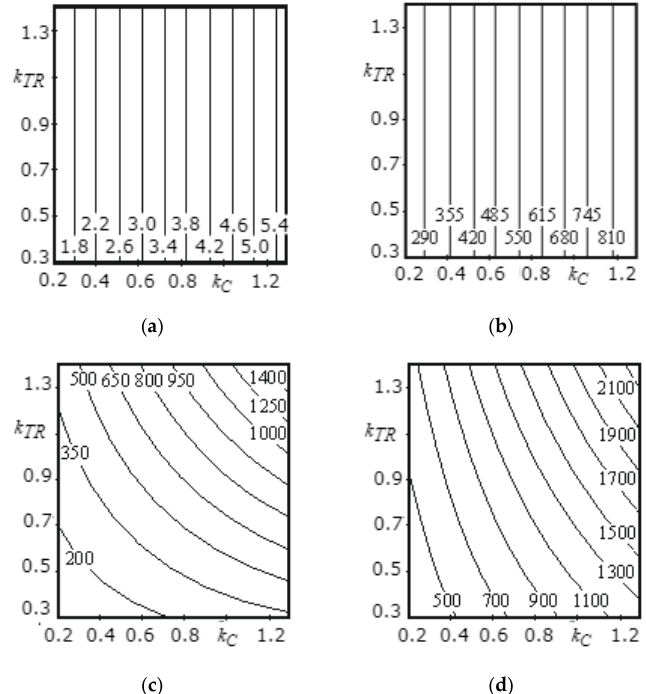
Figure 9. Dependence of the power value on the material coefficient of friction against steel and a material against material for the middle screw: ( a ) the surface constructed based on calculations of the second component; ( b ) the surface constructed based on calculations on the second component; ( c ) the surface constructed based on calculations on the third component; ( d ) the surface representing the change in the total power value for all three components.